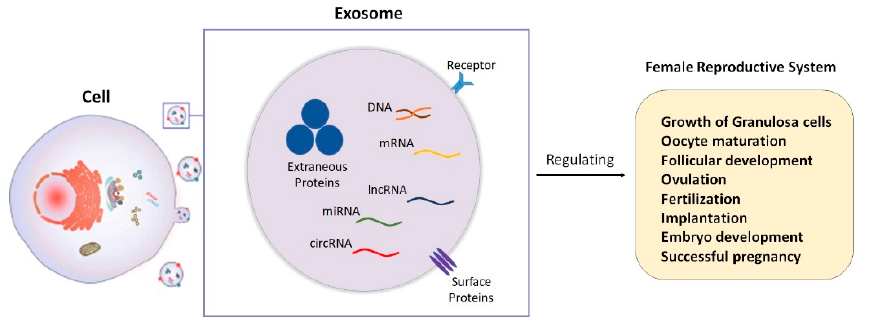
Figure 1. A schematic of the role of exosomes in different biological activities of female reproductive system.